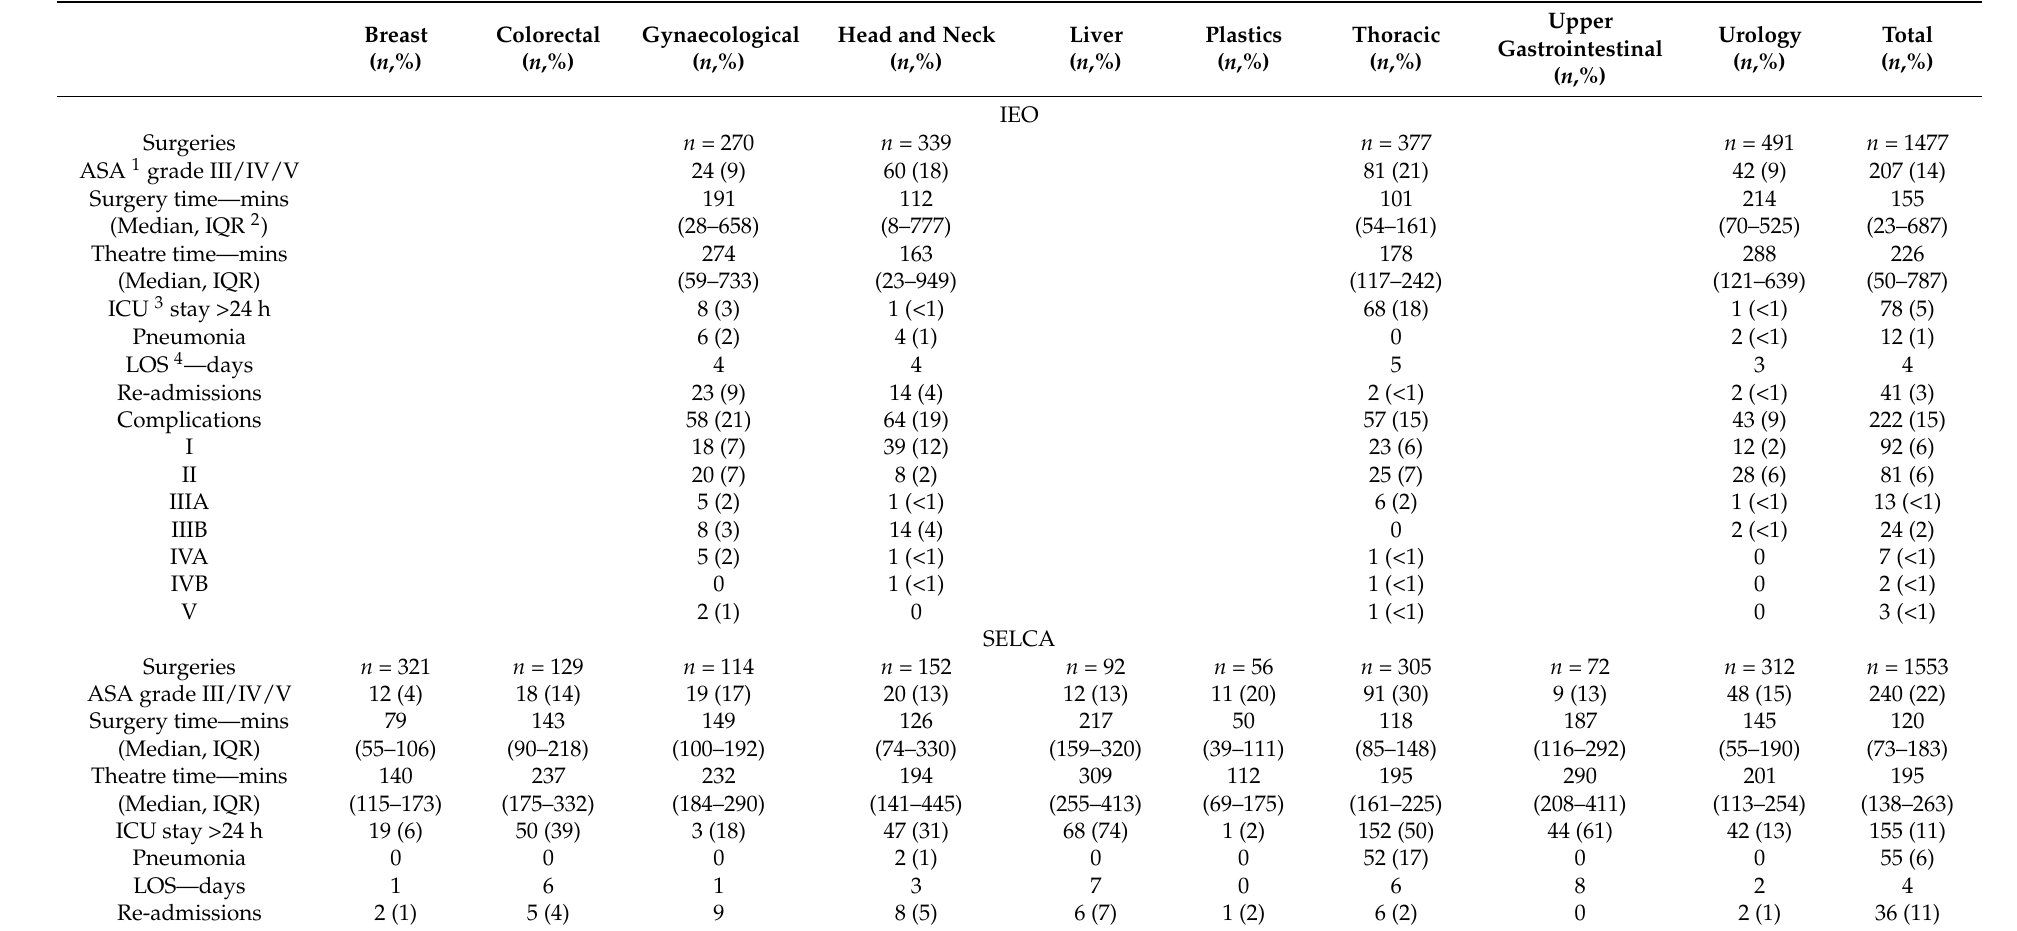
Table 2. Surgical outcomes of IEO and SELCA patients receiving radical treatment from between 1 March 2020–30 September 2020 and 23 March 2020–8 September